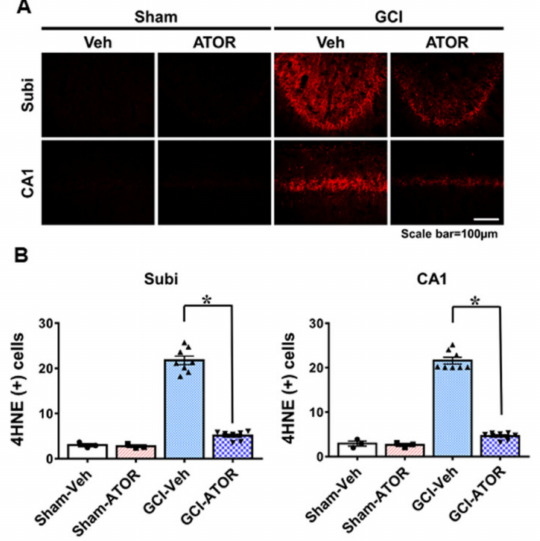
Figure 2. Atorvastatin reduces ischemia-induced oxidative stress. Neuronal oxidative stress was detected through 4HNE (red color) staining in CA1 and subiculum 1 week after ischemia. The sham-operated groups showed a weak red fluorescence in hippocampal CA1 and subiculum. The GCI-ATOR group showed a weaker 4HNE fluorescence intensity compared with the GCI-Veh group ( A ). Scatter dot plot bar graph represents the quantified 4HNE intensity in each region ( B ). Data are mean ± S.E.M.; n = 3 for each sham group, n = 8 for each ischemia group. * Significantly different from the vehicle-treated group, * p < 0.05.